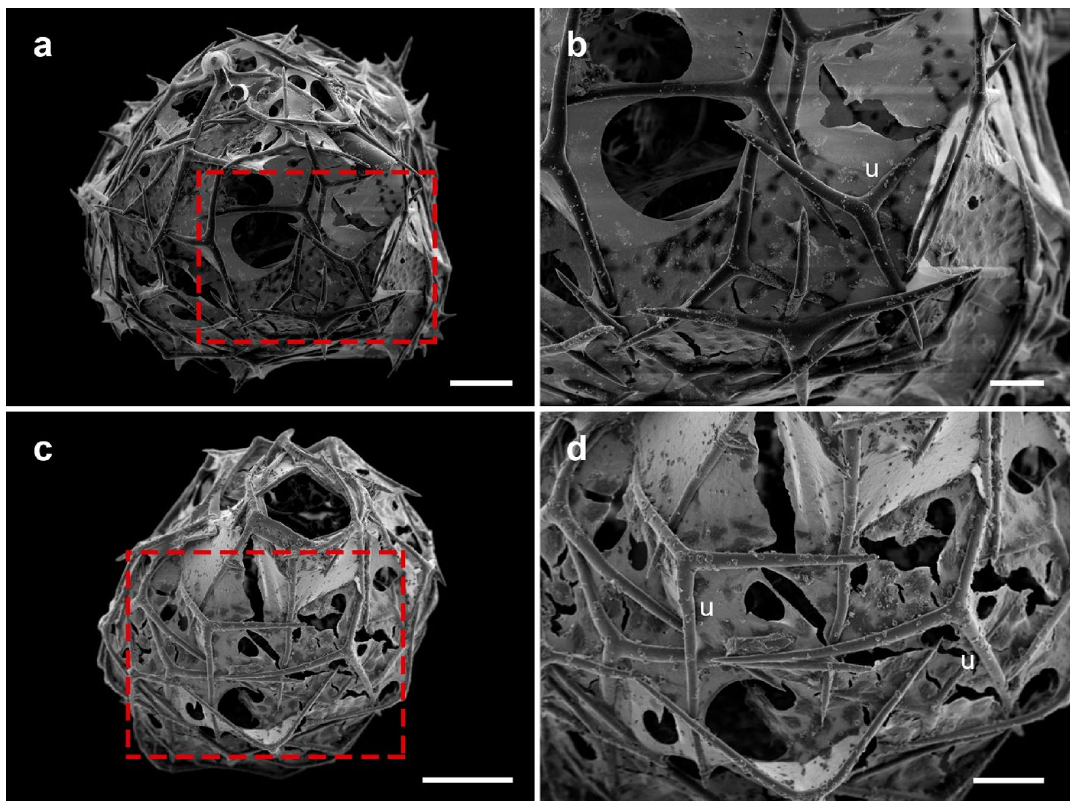
Figure 2. Detail of the shape of the spicules (SEM images) in ( a , b ) control; and ( c , d ) low pH. Red squares in ( a ) and ( c ) correspond to images ( b ) and ( d ), respectively. Scale bars = ( a , c ) 50 µm; and ( b , d ) 20 µm. u = unpaired